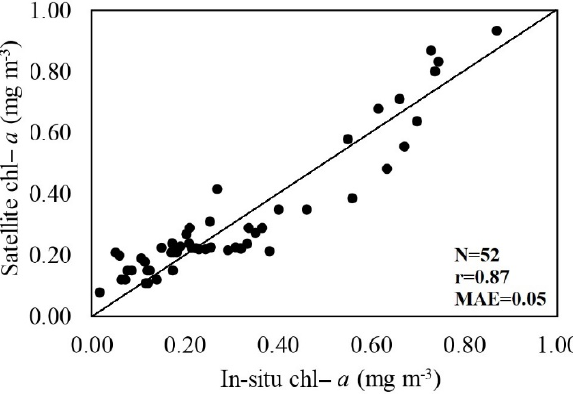
Figure 4. Validation of reconstructed satellite chl − a using the in situ chl − a.